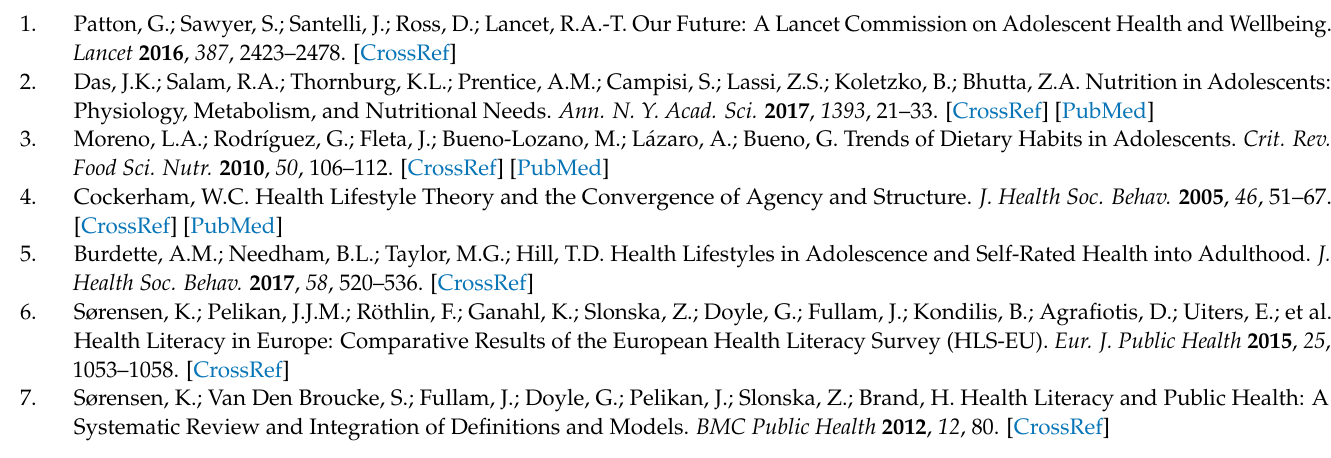
consumed daily; Table S2: Univariate logistic regression models for regularity of meals consumed daily; Table S3: Univariate logistic regression models for the variable related to the most abundant meal; Table S4: Univariate logistic regression models for the consumption of fruit and vegetables; Table S5: Univariate logistic regression models for the consumption of fast